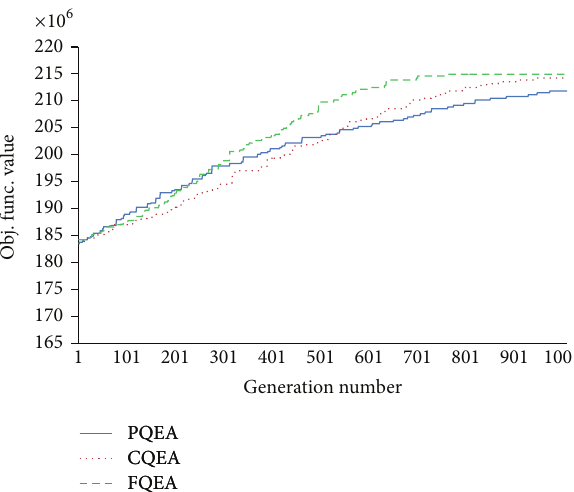
Figure 9: Convergence graph of PQEA, CQEA, and FQEA on COUNTSAT problem size, 𝑛 , being 200.